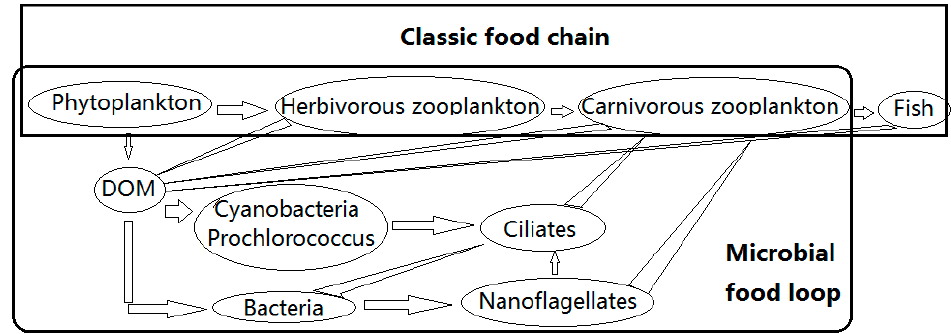
Figure 1. Microbial food loop and classic food chain.